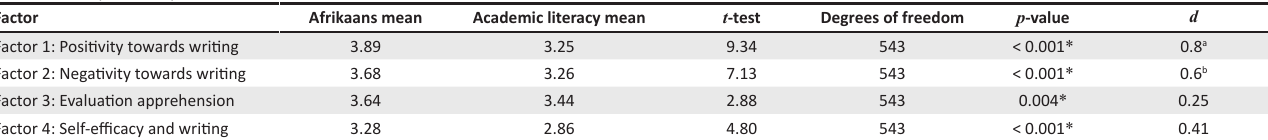
TABLE 4: Comparison by module. Factor